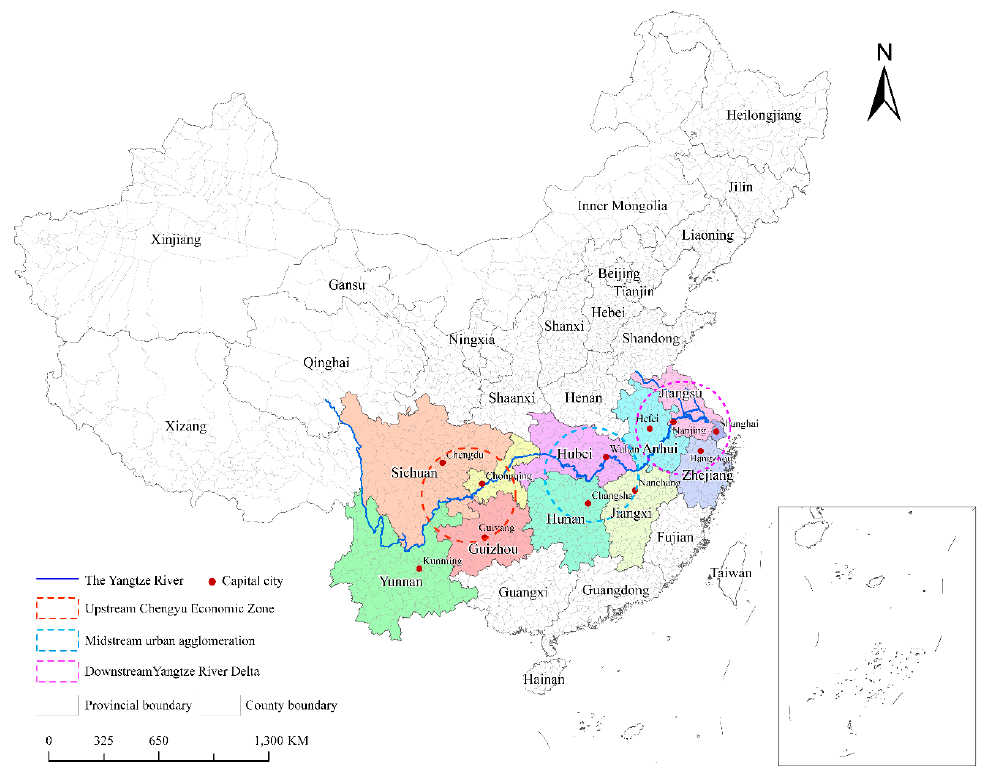
Figure A2. Geographical Distribution Map of the Yangtze River Economic